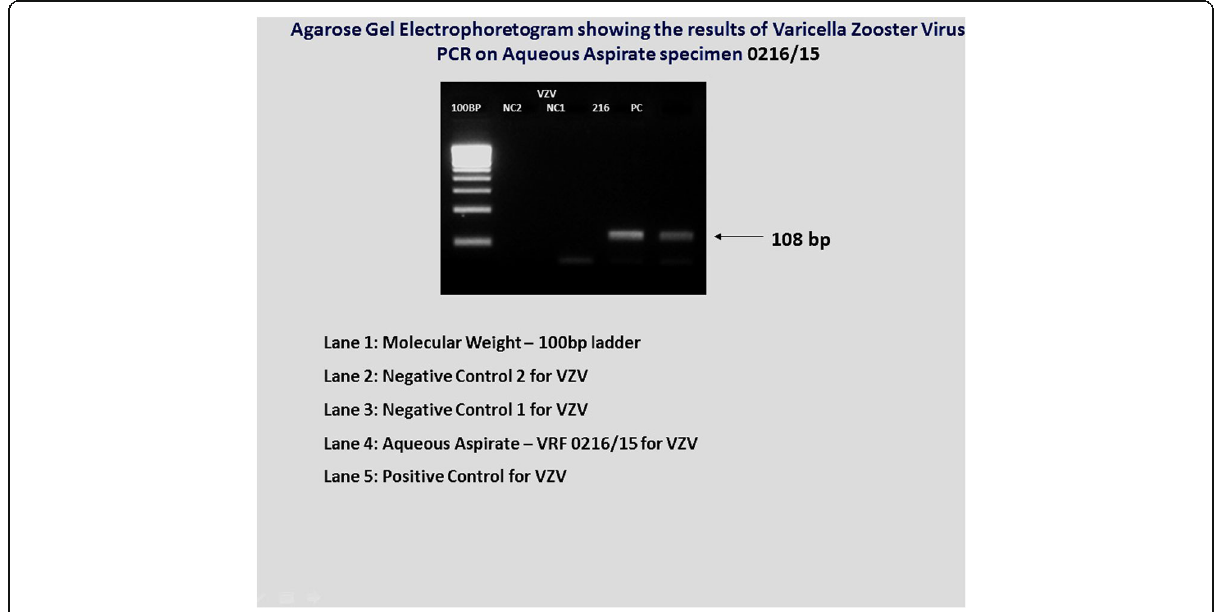
Fig. 3 Agarose gel electophotogram showing the detection of varicella zoster virus (VZV)